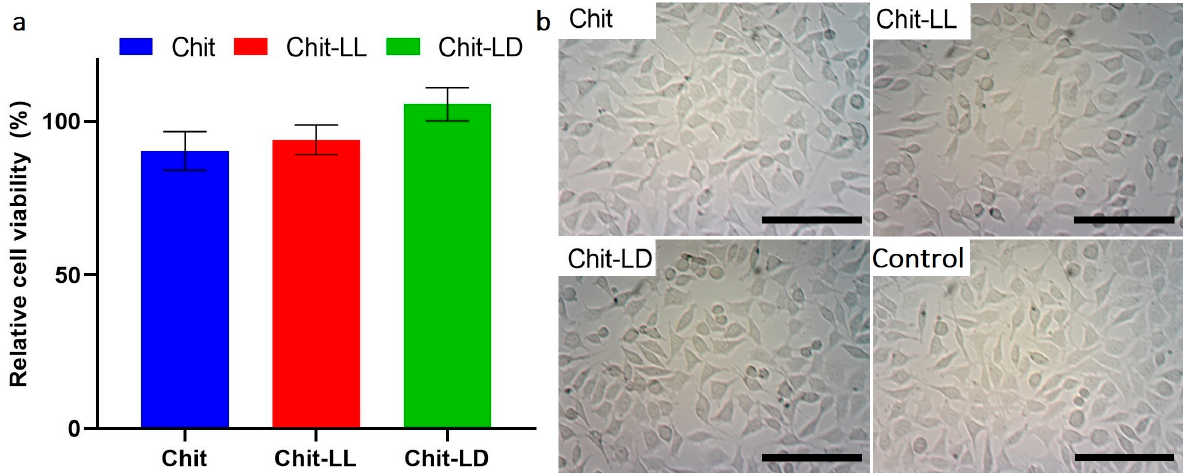
Figure 5. Cell viability after incubation of the L929 mouse fibroblasts in the extracts for 24 h ( a ) and cell morphology ( b ). The results of the MTT-assay. The cells cultivated in DMEM (10% FBS) were